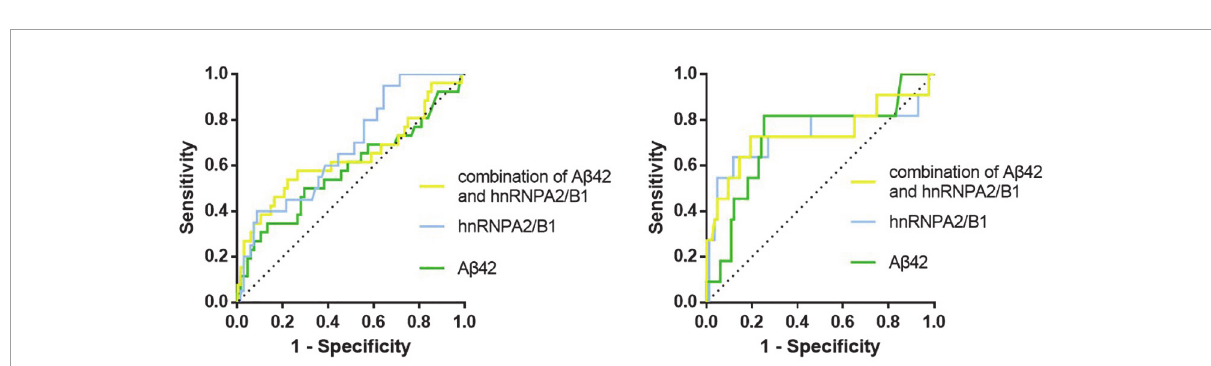
FIGURE5 ROC curves for preoperative biomarkers. The figure showed the ROC curves for hnRNPA2/B1, A β 42 and their combination at 7 days (Left) and 3 months (Right) after surgery, respectively.